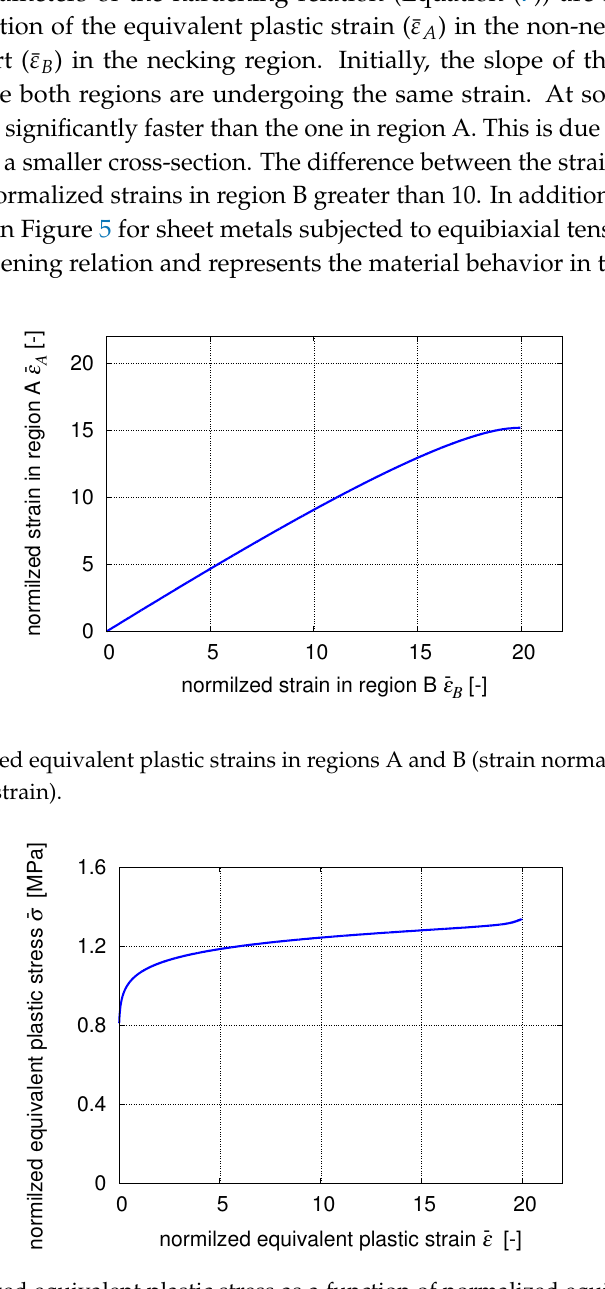
Figure 5. Normalized equivalent plastic stress as a function of normalized equivalent plastic strain under equibiaxial tension (stress and strain normalized with respect to the mean ultimate tensile strength and the mean uniform strain,